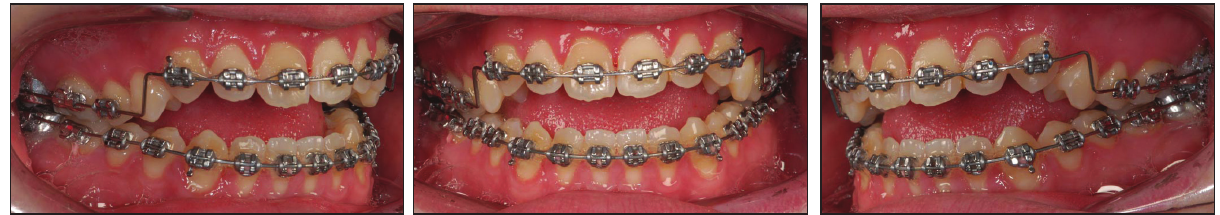
Figure 4. Pre-surgical orthodontic treatment showing the stepped archwire mechanics in the maxillary arch. The upper first premolars have been bypassed because of their planned extraction. Appliances used were pre-adjusted edgewise (0.022 x 0.028 inch slot with MBT ® prescription).